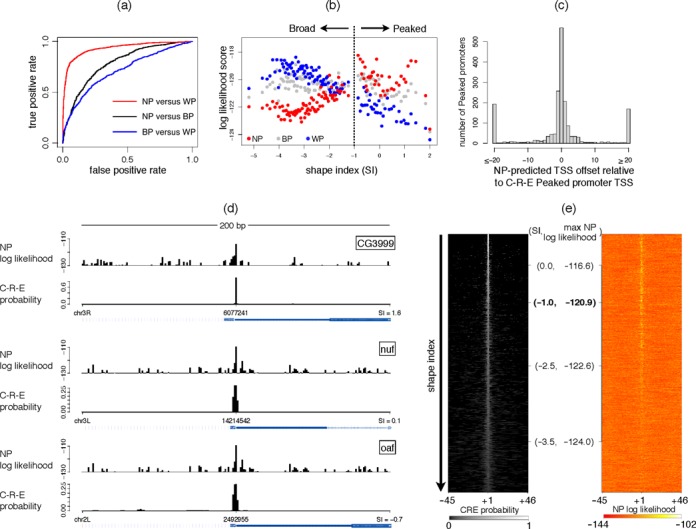
Predictive power of PEAT models. (a) Models from the cross-validation training sets were used to compute log odds scores on respective test sets and ROC curves were used to evaluate three classifiers: NP versus WP (red), NP versus BP (black) and BP versus WP (blue). NP and WP sets are the most separable based on JAPL models. (b) All positions within a C-R-E promoter are tested for being a TSS and the highest likelihood is returned for each of the three PEAT models. The promoters are ordered according to increasing SI on the X-axis and each point corresponds to the average log likelihood score of a bin of 50 promoters according to NP (red), BP (grey) and WP (blue). NP log likelihoods are positively correlated with the SI, while WP log likelihoods are negatively correlated with the SI (P-value < 10−16 for both). The BP log likelihoods have a weak negative correlation with the SI (P-value < 10−4). (c) A histogram of the relative offset of a prediction of the TSS in the Peaked C-R-E promoters by the PEAT NP model with respect to the reported mode of the distribution is shown. (d) The C-R-E TSS probability distribution and the NP model predictions are plotted for the three Peaked promoters used by Hoskins et al. for illustration purposes in their paper. (e) The C-R-E TSS probability distributions over all promoters not in the PEAT dataset are ordered according to their SI on the left. The NP model log likelihoods of TSSs over the corresponding regions are shown on the right. The position of the demarcator SI of −1 for Peaked promoters is shown in bold.